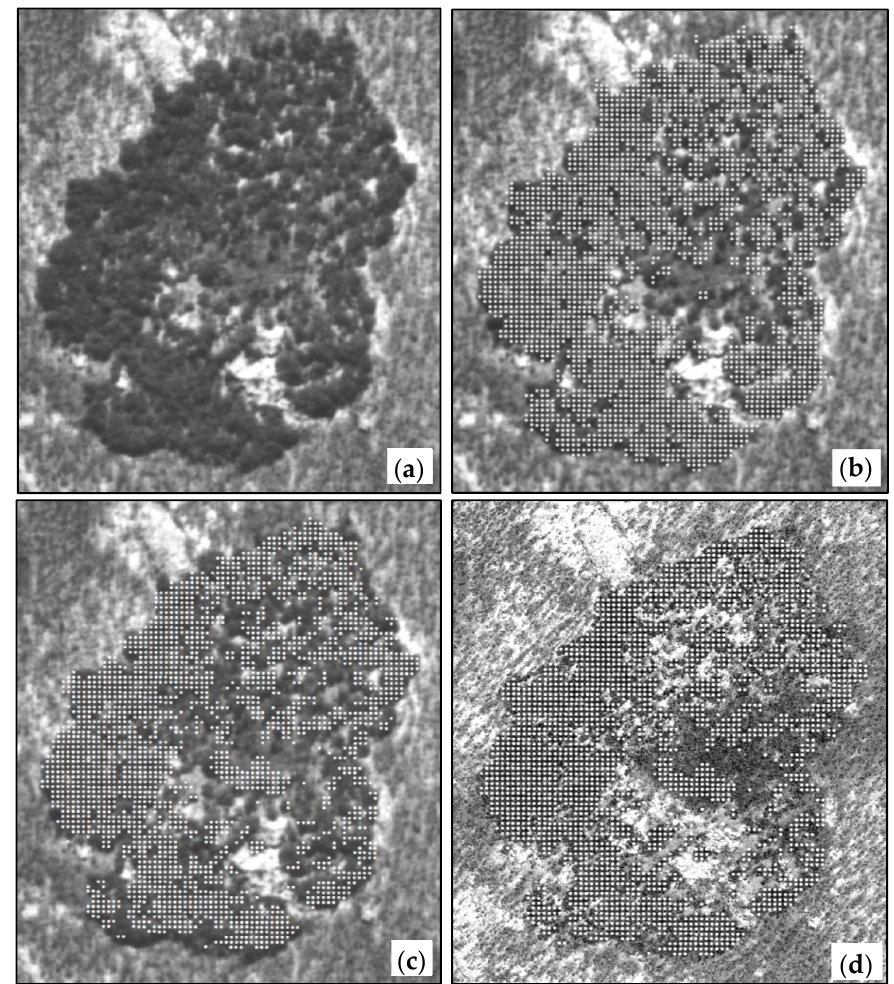
Figure 2. Assessing change at an Allosyncarpia sample site: ( a ) 1950 aerial photo; ( b ) 1950 image with 1982 canopy cover points; ( c ) 1950 photo with 2010 canopy cover points; ( d ) 2010 photo with 2010 canopy cover points.